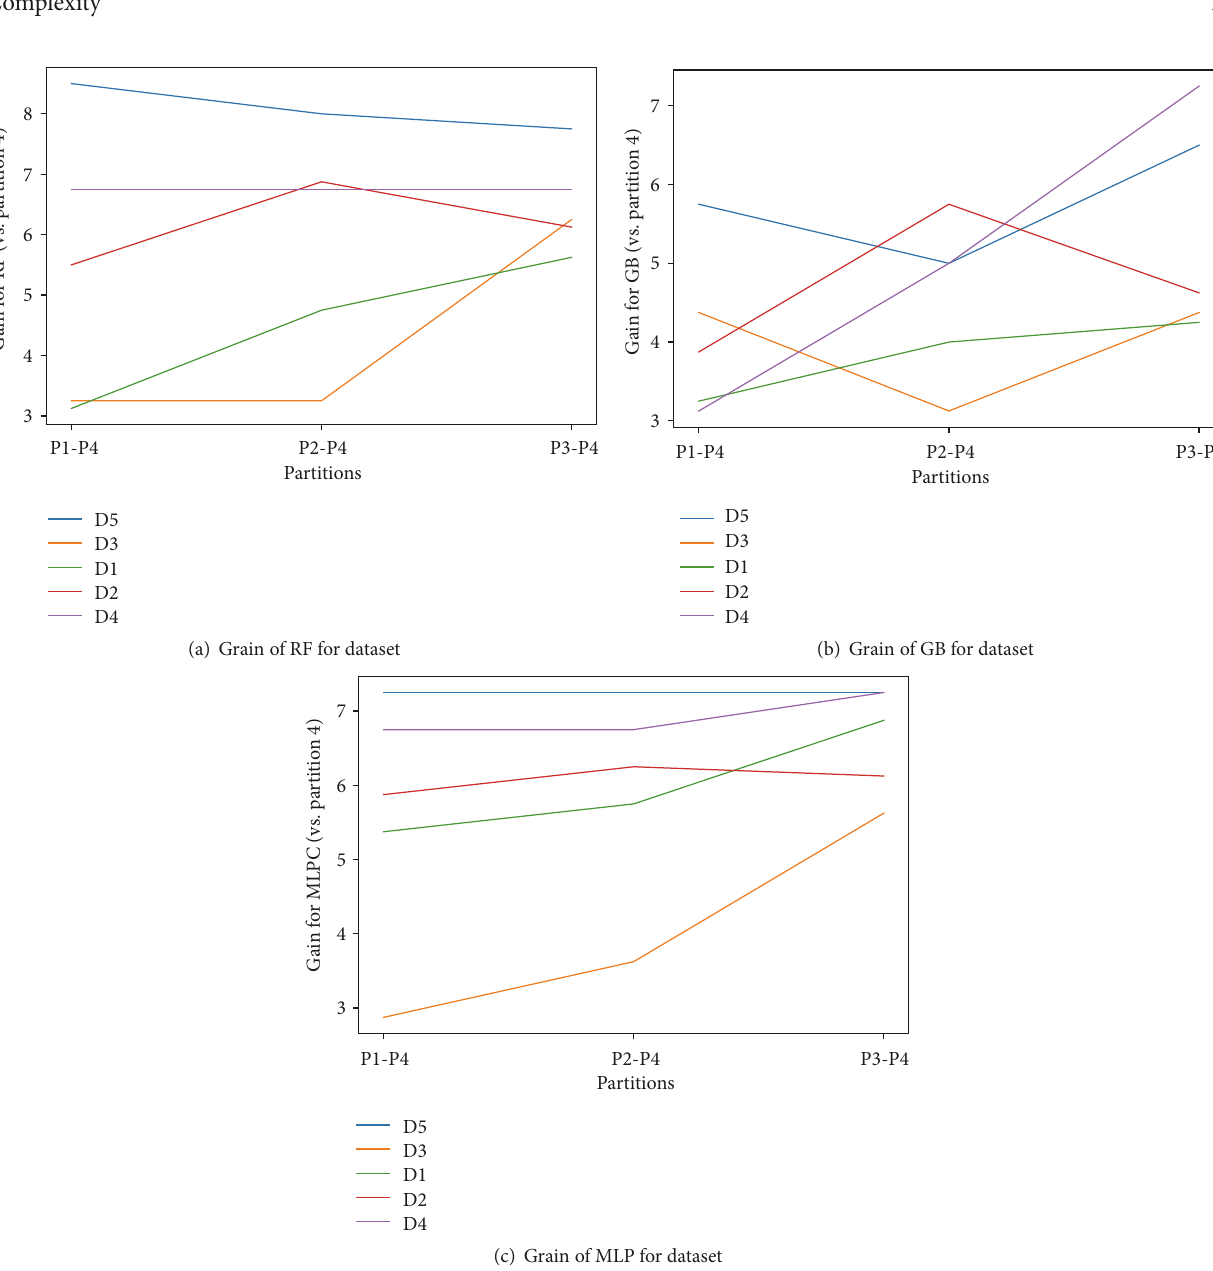
Figure 7: Average of gain for each smaller partition with respect to the whole dataset in each dataset 𝐷 𝑖